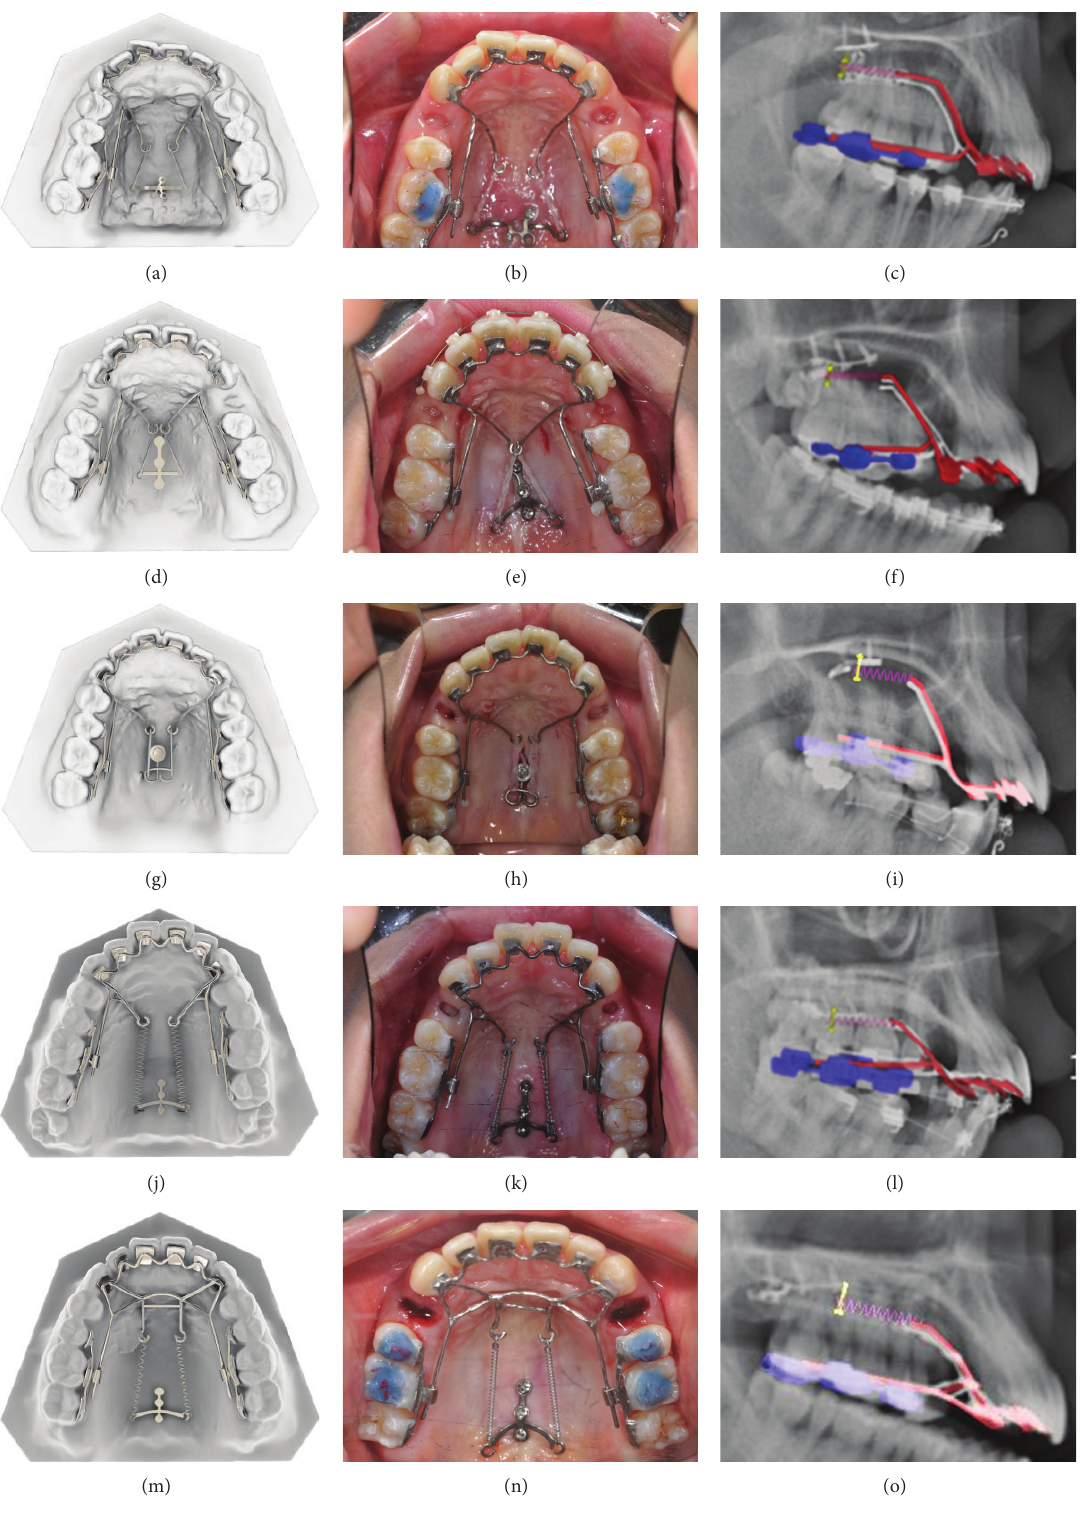
Figure 6: 3D KILBON appliance in the CAD software, occlusal photograph and lateral cephalograms. Positional accuracy and rigidity of each design were evaluated by comparing the planned design on the 3D model with a new occlusal photograph and by superimposing a new lateral cephalogram on the initial cephalogram containing design information in the 3Txer